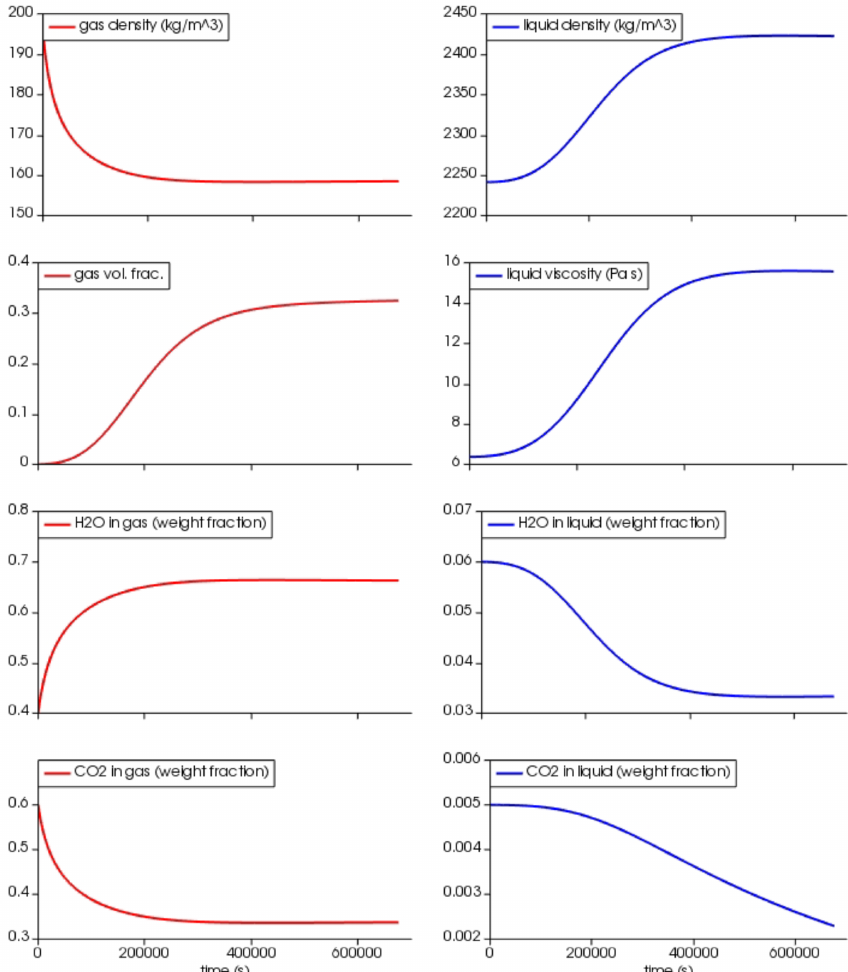
Figure 13. Reacting box simulation. At time 0 a small amount of gas (volume fraction α g = 10 − 4 ) is uniformly distributed in the box, and the basaltic melt is oversaturated in H 2 O (5wt%) and CO 2 (5000ppm) at 80MPa and 1373K. The diffusion coefficients for H 2 O and CO 2 in the basalt are 10 − 9 and 10 − 10 m 2 s − 1 , respectively (Baker et al., 2005). Isobaric specific heat capacities in the gas phase are = 2900 J kg − 1 K − 1 and C P = 1390 J kg − 1 K − 1 (https://webbook.nist.gov/, last access: 27 April 2022, Beaton et al., 1987) C P g , H2O g , CO2 = 2278Jkg − 1 K − 1 , C P = 1600Jkg − 1 K − 1 , and C P = 1600Jkg − 1 K − 1 (Lesher and Spera, 2015). and in the liquid phase C P l , H2O l , CO2 b asalt Thermal conductivity of the liquid is 1 . 5WK − 1 m − 1 (Lesher and Spera, 2015); for the gas phase Prandtl numbers of 0.9 for H 2 O and 0.7 for CO 2 are used, corresponding to thermal conductivities of 0.16 and 0.09WK − 1 m − 1 (https://webbook.nist.gov/, last access: 27 April 2022, Beaton et al.,